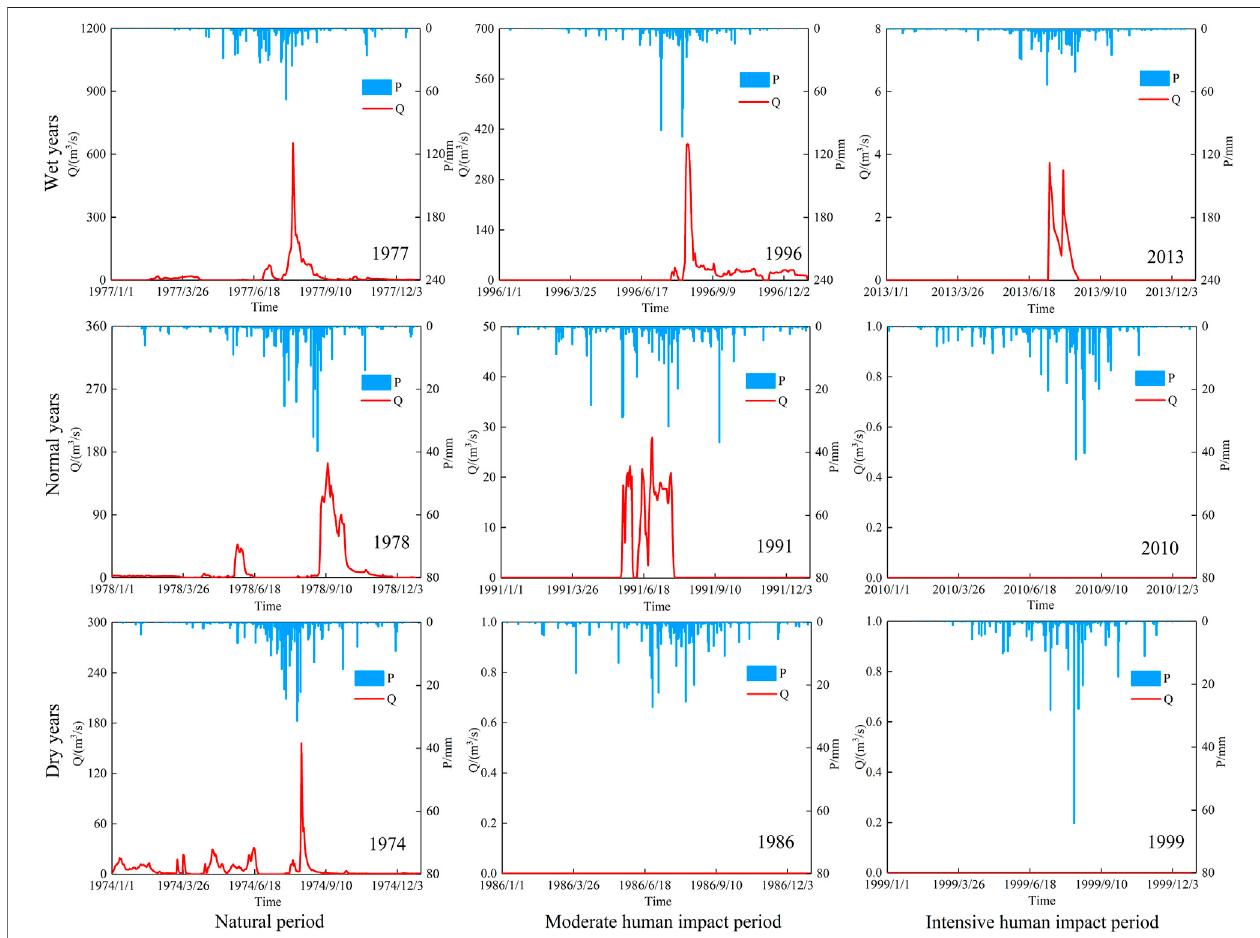
FIGURE 8 | Daily discharge processes for typical years with a same precipitation situation in different periods.